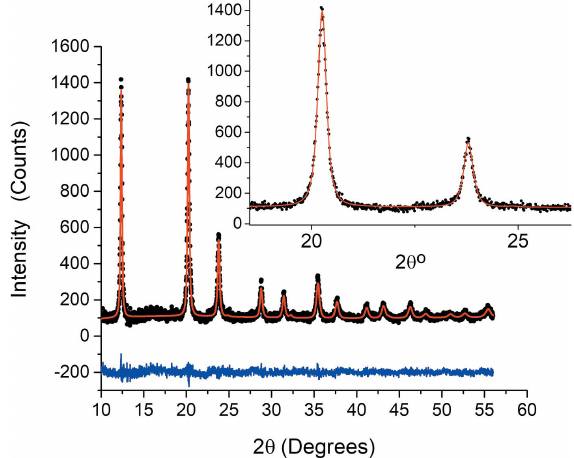
Figure 12 Whole Powder Pattern Modelling (WPPM) fitting for ball-milled CaF2. Experimental data are circles and the refined model is a line. The difference plot is shown below.